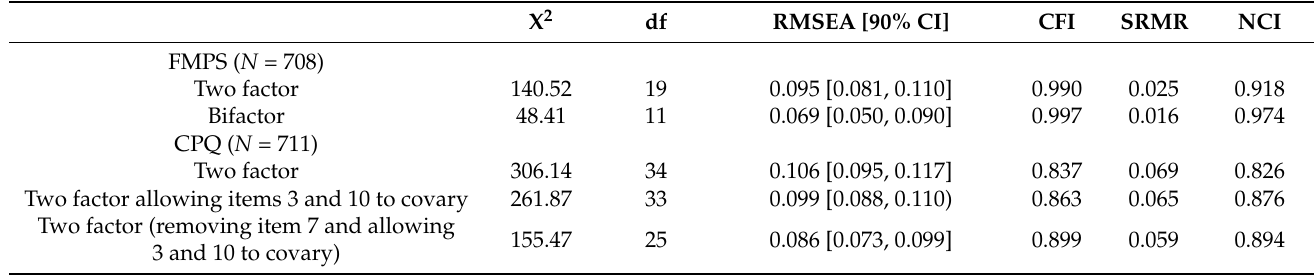
Table 2. Baseline model fit statistics.